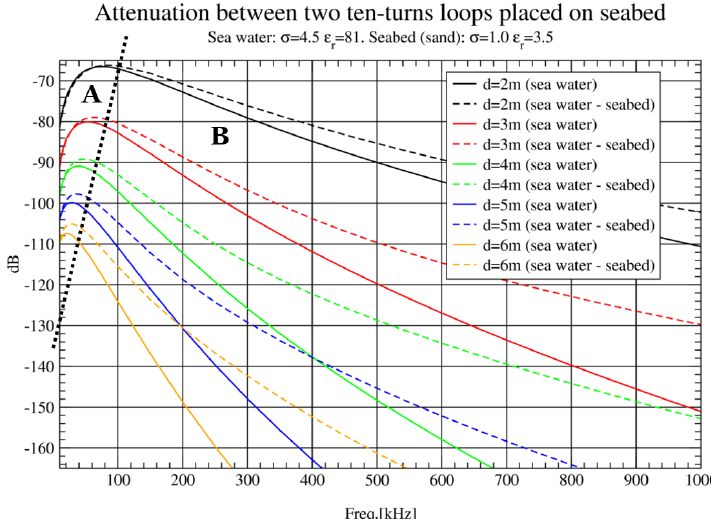
Figure 7. Influence of seabed layer inclusion in